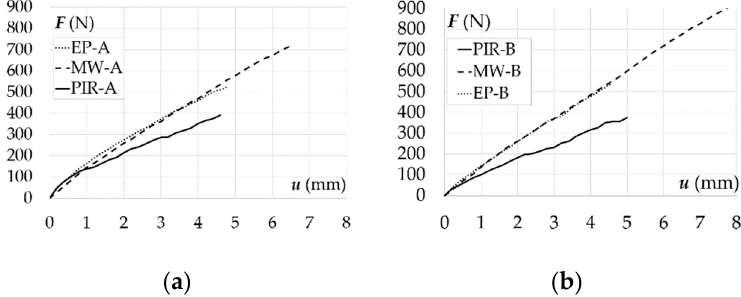
Figure 10. Load-displacement relations for the pull-out of a blind rivet installed in sandwich panels with various core materials: ( a ) static axial load—case A, ( b ) quasi-cyclic axial load—case B.